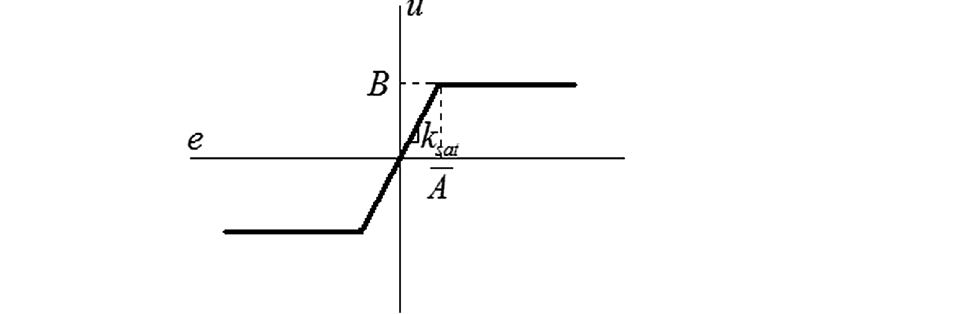
Figure 4. The static characteristics of the saturation